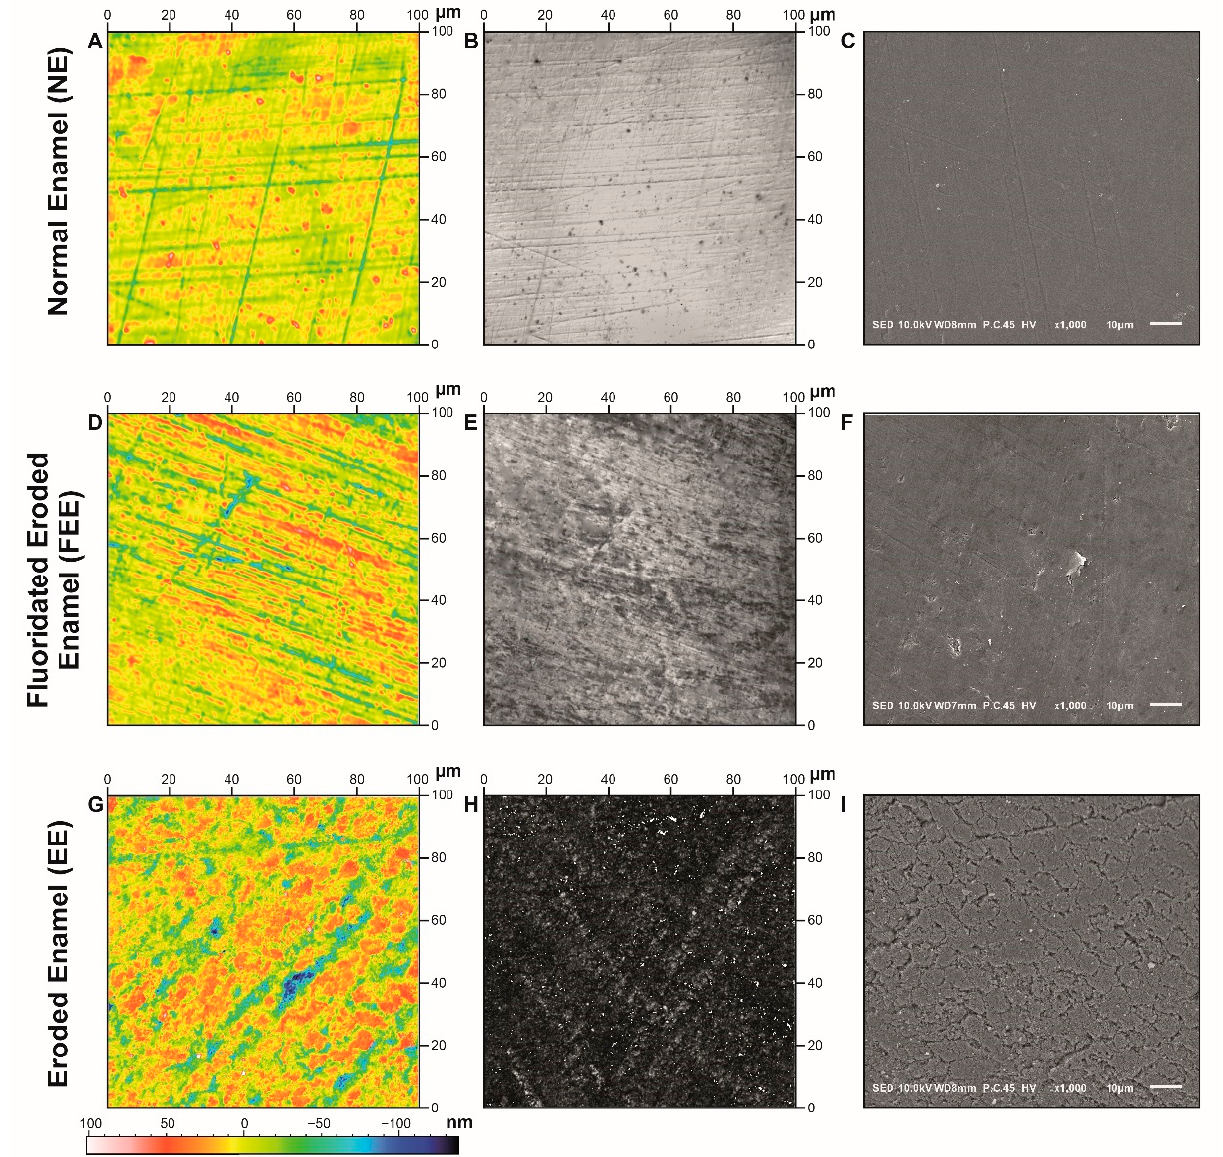
Figure 3. Representative images of enamel qualitative characteristics: NE group ( A – C ), FEE group ( D – F ), and EE group ( G – I ). The left column ( A , D , G ) presents the heights heat map; the middle column ( B , E , H ) presents the confocal microscopy photo simulation images; the right column ( C , F , I ) presents the SEM images. The EE group exhibited the greatest surface damage and notably rougher surface than the FEE and NE. This can be noted by the heat map images illustrating greater height differences (more red and blue vs. yellow). The darkness of the images in the middle column reflects the surface damage, as higher roughness induces light to disperse. The irregularity of the surfaces can be noted in the SEM images (right